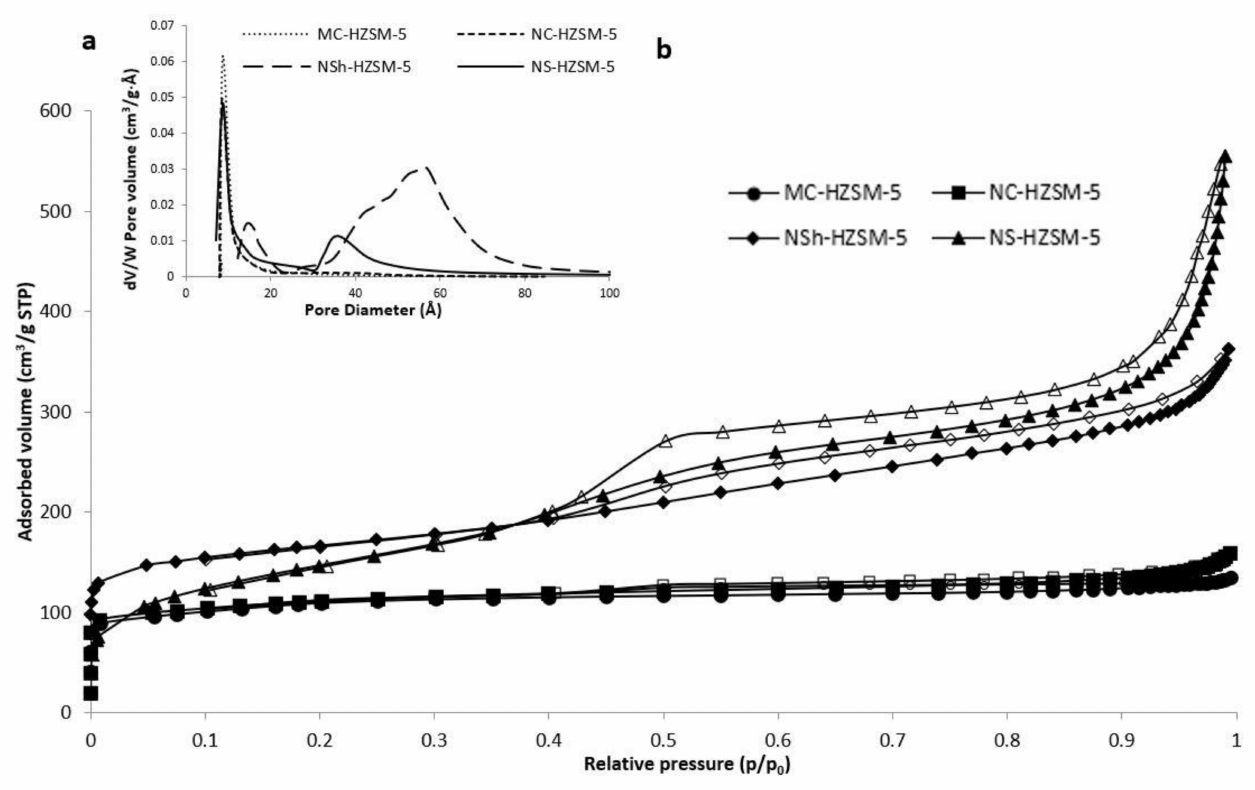
Figure 4. ( a )Adsorption/desorption isotherms of nitrogen on the calcined MC-HZSM5, NC-HZSM5, NSh-HZSM5, and NS-HZSM5 samples, at − 196 ◦ C, ( b ) Micropore and mesopore size distribution of the exchanged and calcined